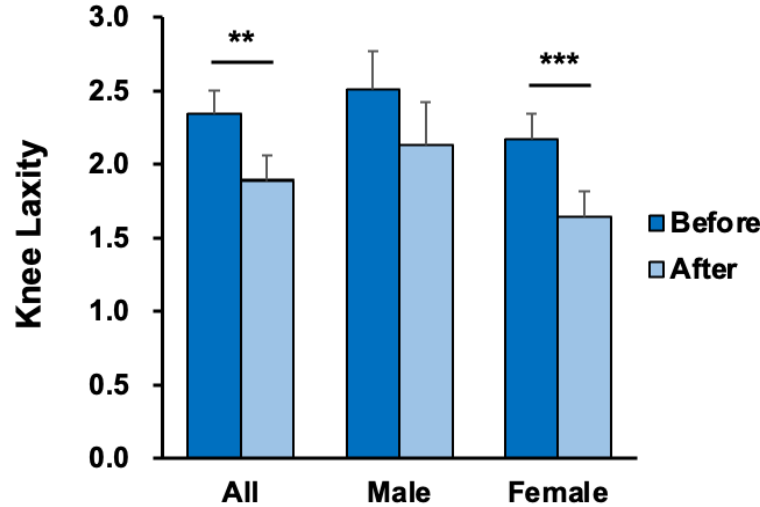
Figure 4. Comparison of anterior–posterior knee laxity of the dominant leg before and after dynamic taping (mean ± SE). ** p < 0.01, and *** p < 0.001; each indicates a significant difference before and after taping.